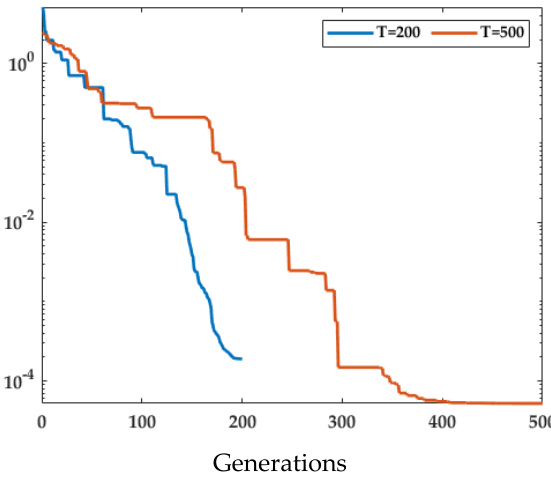
Figure 8. Fitness plots for MPA w.r.t generation variations for case study 2.